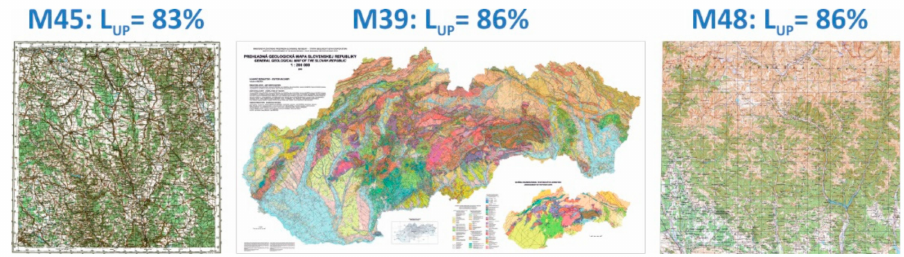
Figure 6. MapswiththehighestL UP valuesalsomarkedbyrespondentsasoverloadedinL SE (twosections of topographic maps and a geological map of